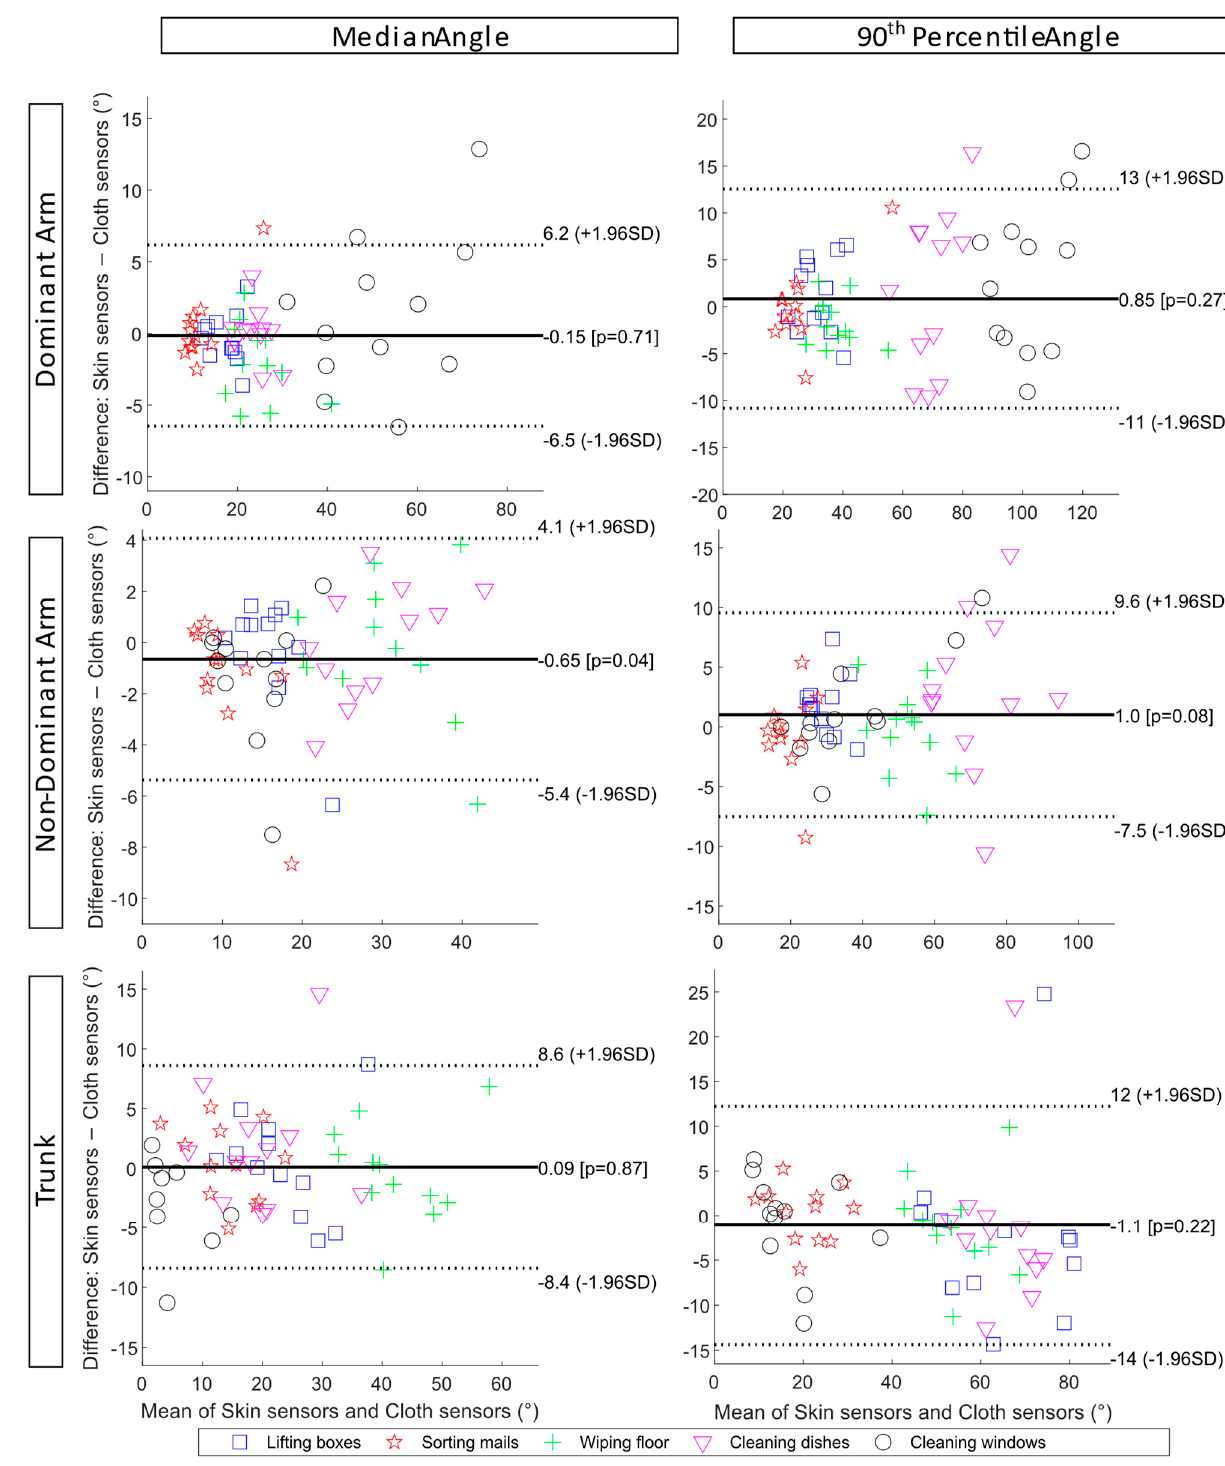
Figure 4. Bland–Altman plots of the upper arm inclination and trunk forward inclination angle during the five simulated work tasks show the limits of agreements between skin sensors and cloth sensors. From top to bottom: the dominant arm, the non-dominant arm, and the trunk. To the left are the median angles, and to the right are the 90th percentile angles.